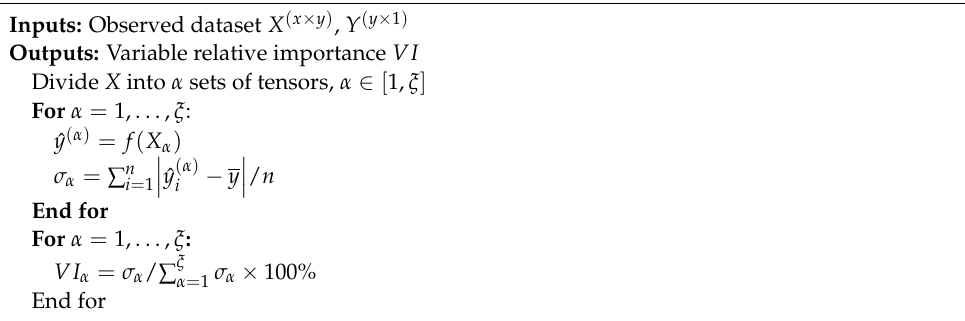
Algorithm 2 Variable importance measure for predictive model